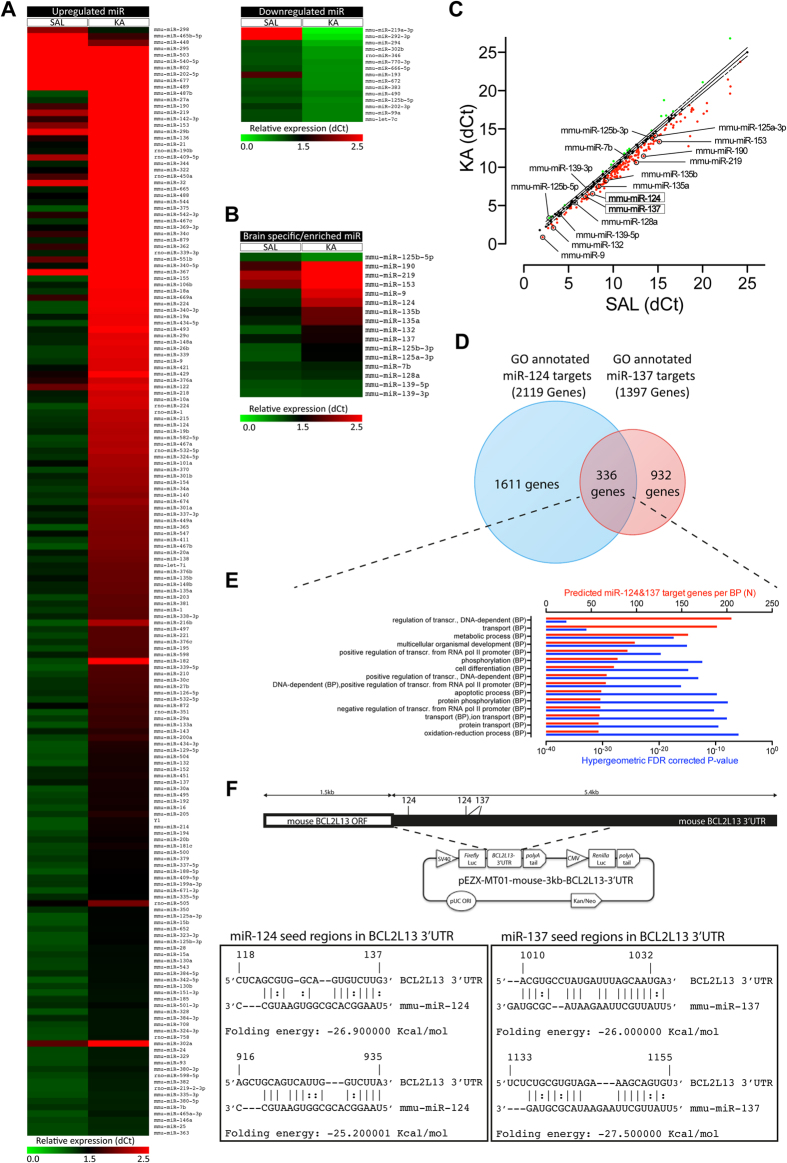
KA-SE induced changes miR expression profile in the DG.(A) Relative expression level (dCt) of 189 miRs significantly dysregulated in the DG of mice exposed to KA-SE, (FDR corrected p < 0.05; cutoff fold change ≥1.5). (B) Relative expression levels (dCt) of a group of brain- enriched or -specific miRs (FDR corrected p < 0.05; cutoff fold change ≥1.5). (C) Relative expression levels (dCt) of SAL vs. KA showing individual deviations from the RNU6B normalized mean (continuous line) ± SEM (dashed line). Red dots: up- and green dots: down-regulated miRs. Brain- enriched or -specific miR are indicated. (D) miR-mRNA interaction prediction mining for miR-124 and miR-137 with ≥3 algorithms positively predicting miR-mRNA binding. (E) GO analysis of 336 predicted common targets between miR-124 and miR-137. 61 were annotated in apoptotic processes (Hypergeometric FDR corrected p = 1.56*10-10). Red bars: number of annotated members per BP. Blue bars: hypergeometric FDR corrected p -values. (F) BCL2L13 3′UTR with miR-124 and miR-137 seed regions highlighted. Within BCL2L13 mRNA sequence (NM_153516), the 3′UTR starts in position 1483, after a UAA stop codon, where our 3′UTR position numbering starts. The predicted binding regions at position 916 (miR-124) and 1010 (miR-137) met inclusion criteria for cooperative action described in the text. The reporter plasmid with a truncated BCL2L13 3′UTR (first 3 kb of NM_153516) containing predicted miR-124&137 binding regions is schematically depicted. Calculated folding energy and seed pairing details for miR-124 and miR-137 at the BCL2L13 3′UTR are shown in the boxes.